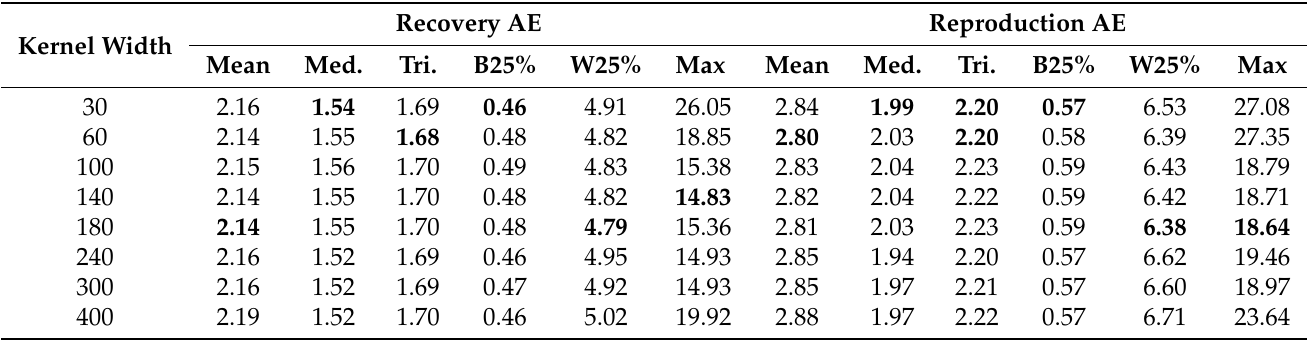
Table 7. Statistical metrics on the Gehler-Shi and Cube+ datasets with different kernel width in KFCM clustering algorithm, where the selected feature combination is RGBuv+ChengSF+IIF, and the cluster number K =